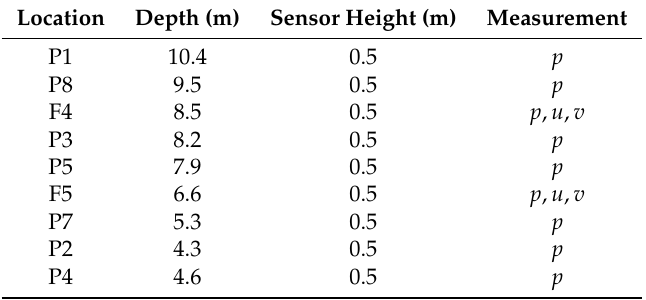
Figure 1. Left panel: Overview map of the Netherlands with the measurement location of the ebb-tidal shoal indicated by a red dot (source: Wikepedia Commons). Right panel: Bathymetric map of Ameland ebb-tidal shoal showing the location of the instrument frames (red circles) and pressure sensors (black circles). The dotted and dashed lines represent the − 5 m and − 10 m contour lines, respectively. Table 1. Overview of measurement locations, the mean depth and sensor height above the bed as deployed in the field, and the quantities which were measured ( p stands for pressure, and u and v are the horizontal components of the velocity